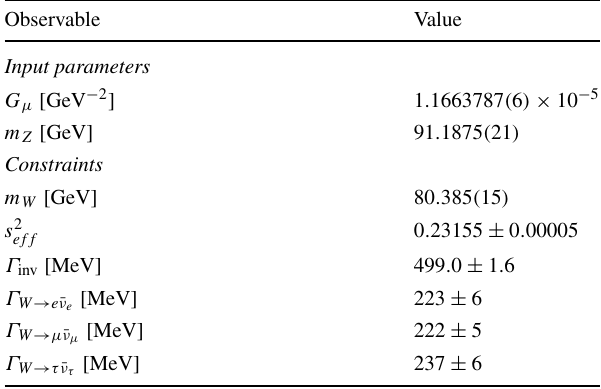
Table 1 Electroweak precision observables measurements and uncer- tainties, taken from Ref. [101] Observable